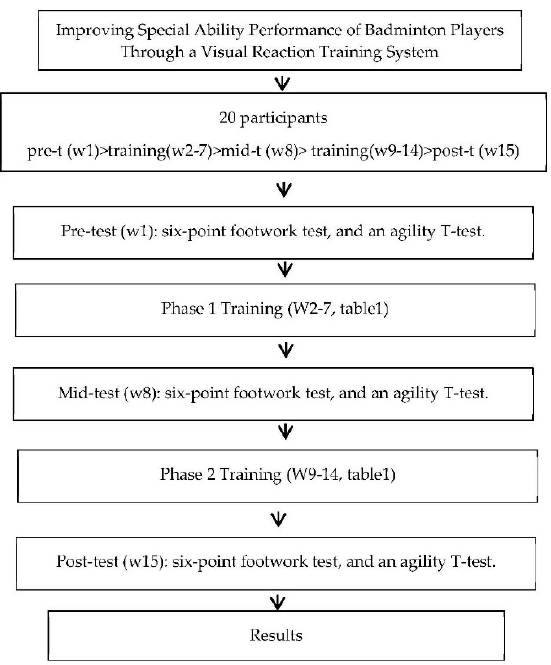
Figure 1. Research